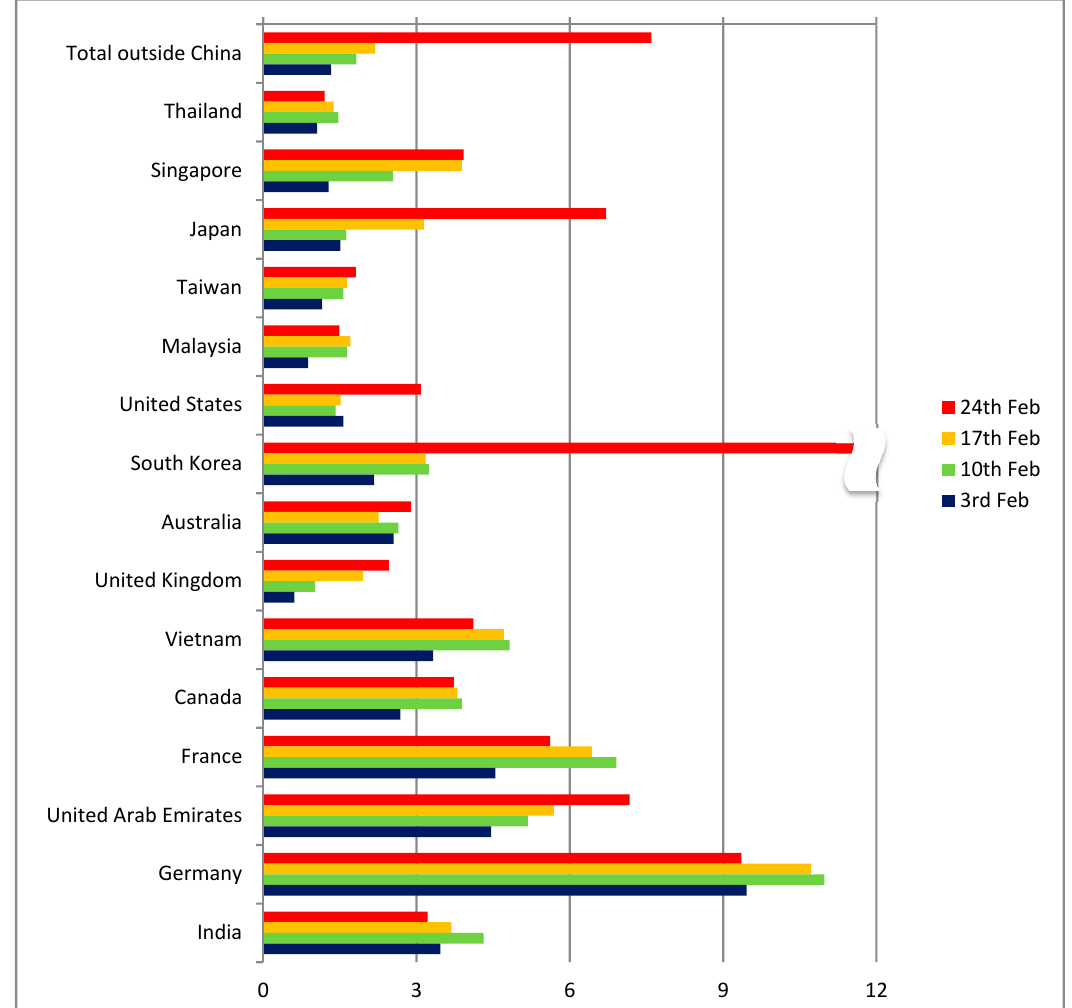
Figure 5. Estimated ratio of infected passengers outside China (cases per 1000 passengers).